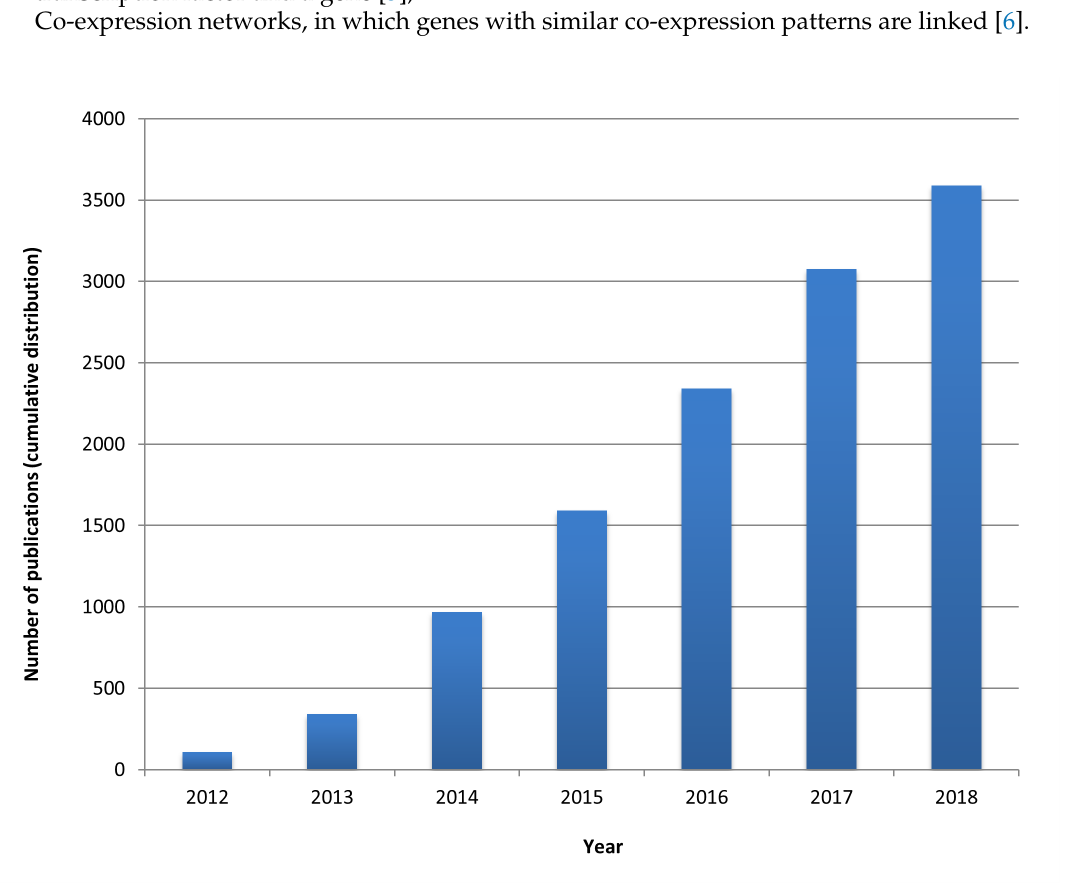
Figure 1. Number of 2012–2018 publications related to network-based approaches to